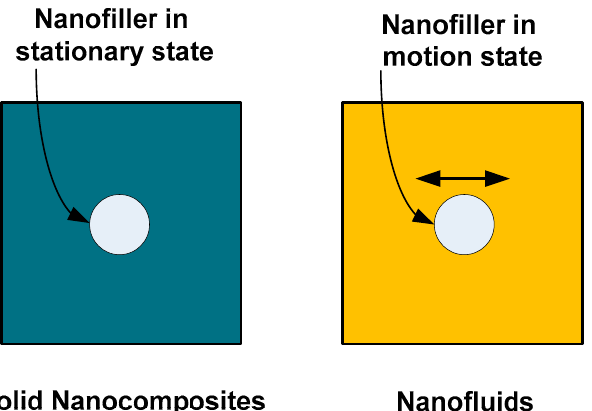
Figure 18. Behavior of nanoparticle inside solid nanocomposites and nanofluids.